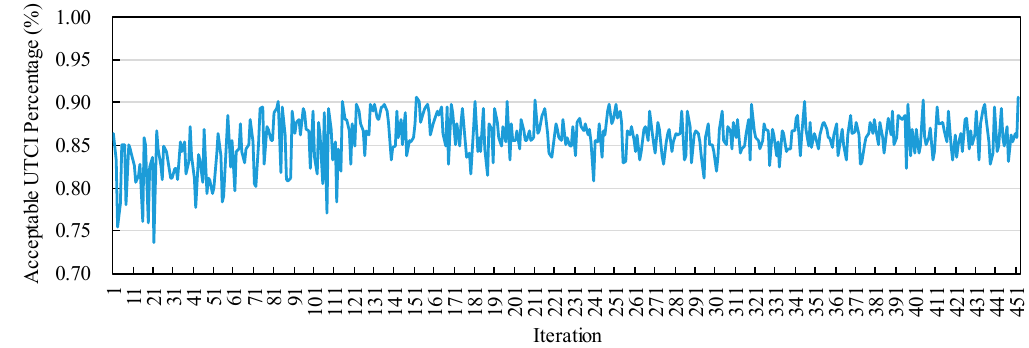
Figure 13. Change trends in comfort ratios generated by Galapagos genetic algorithm at street level.